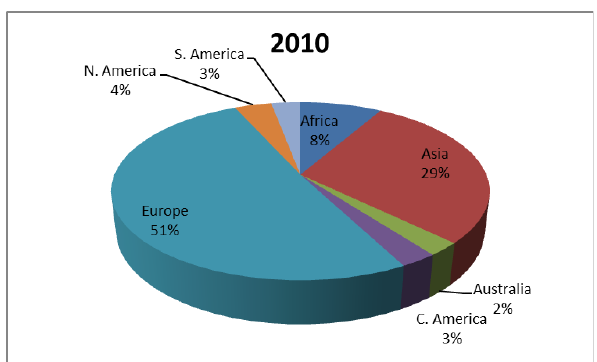
Figure 3. Percentage of members by geographical region for 2010 (Kivilcim et al., 2010).